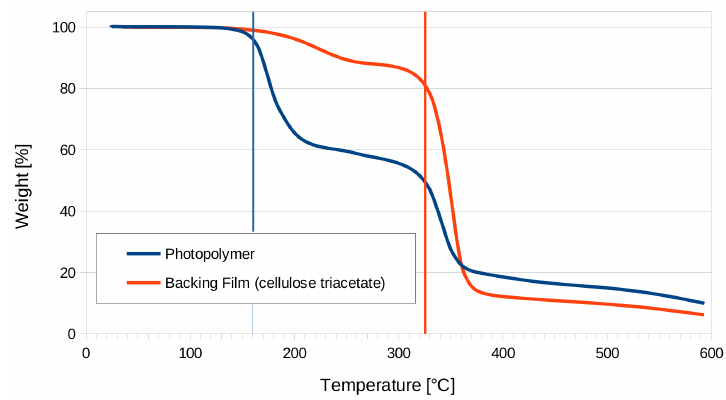
Figure 3. Thermogravimetric analysis of the Bayfol ® HX200 photopolymer and the cellulose triacetate